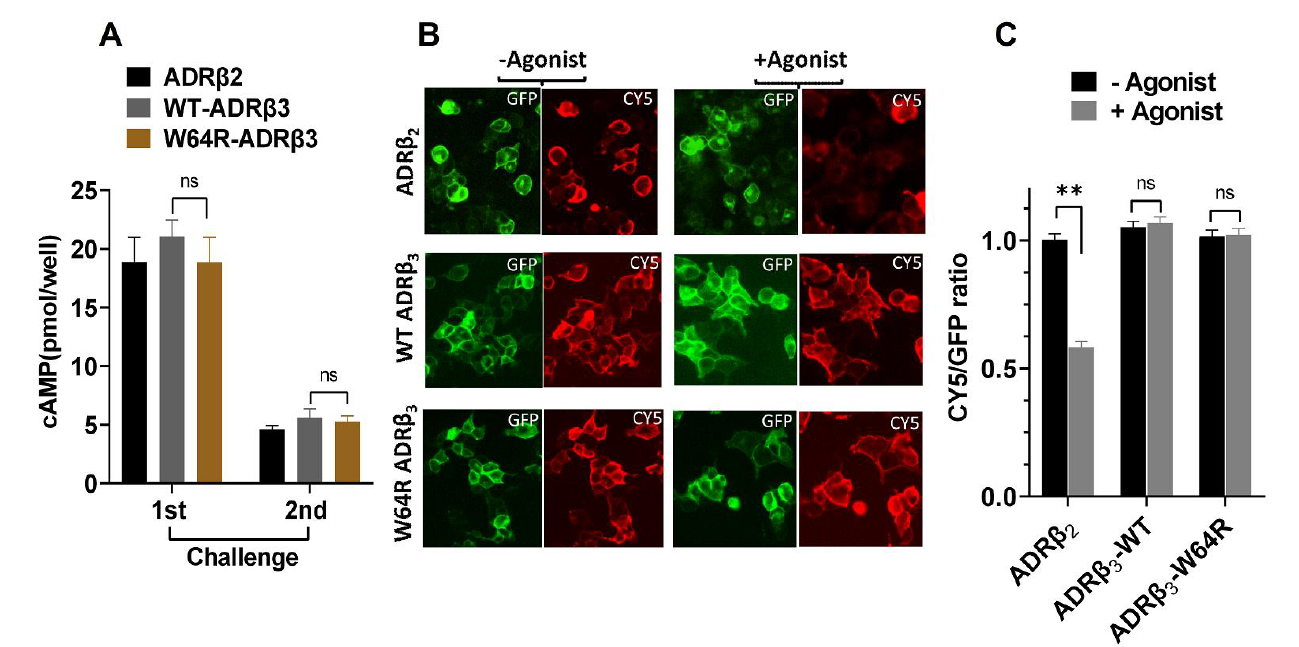
Figure 5. Agonist-induced desensitization of WT and W64R ADR β 3. ( A ) Agonist-induced cAMP formation in cells expressing ADR β 2, WT ADR β 3, and W64R ADR β 3. ( B ) Fluorescent images of cells showing expression HA-ADR β 2-GFP, WT HA-ADR β 3-GFP, and W64R HA-ADR β 3-GFP without and with agonist stimulation. ( C ) Graph showing surface to total cellular expression (Cy5/GFP) of ADR β 2, WT ADR β 3, and W64R ADR β 3 with or without agonist stimulation. Each bar represents an average of three independent experiments. ** p < 0.01 and ns p > 0.05.